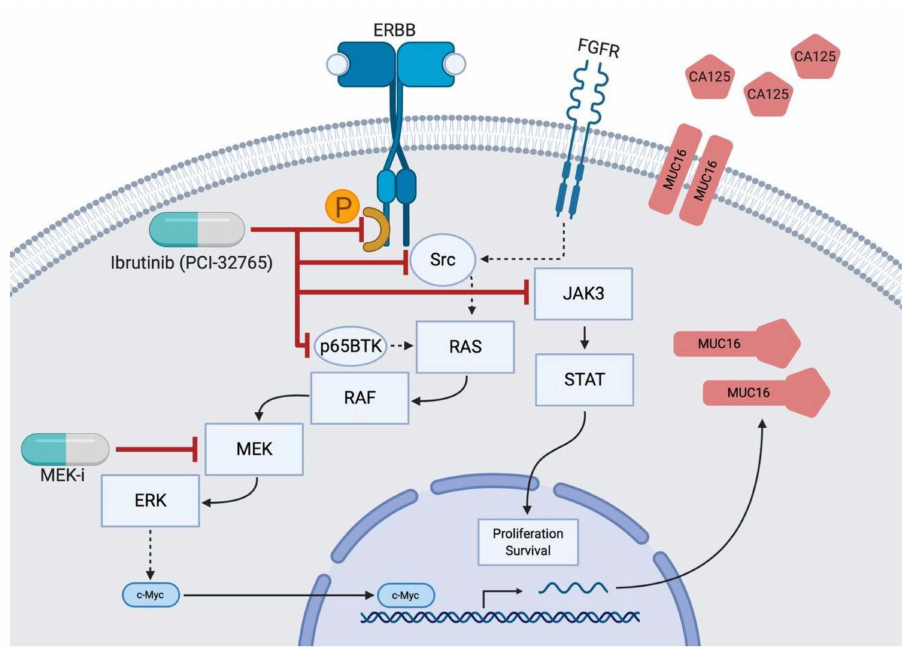
Figure 2. Proposed mechanism of ibrutinib-mediated suppression of CA-125 production along the RAS–RAF–MEK–ERK pathway including additional inhibitory sites (created with